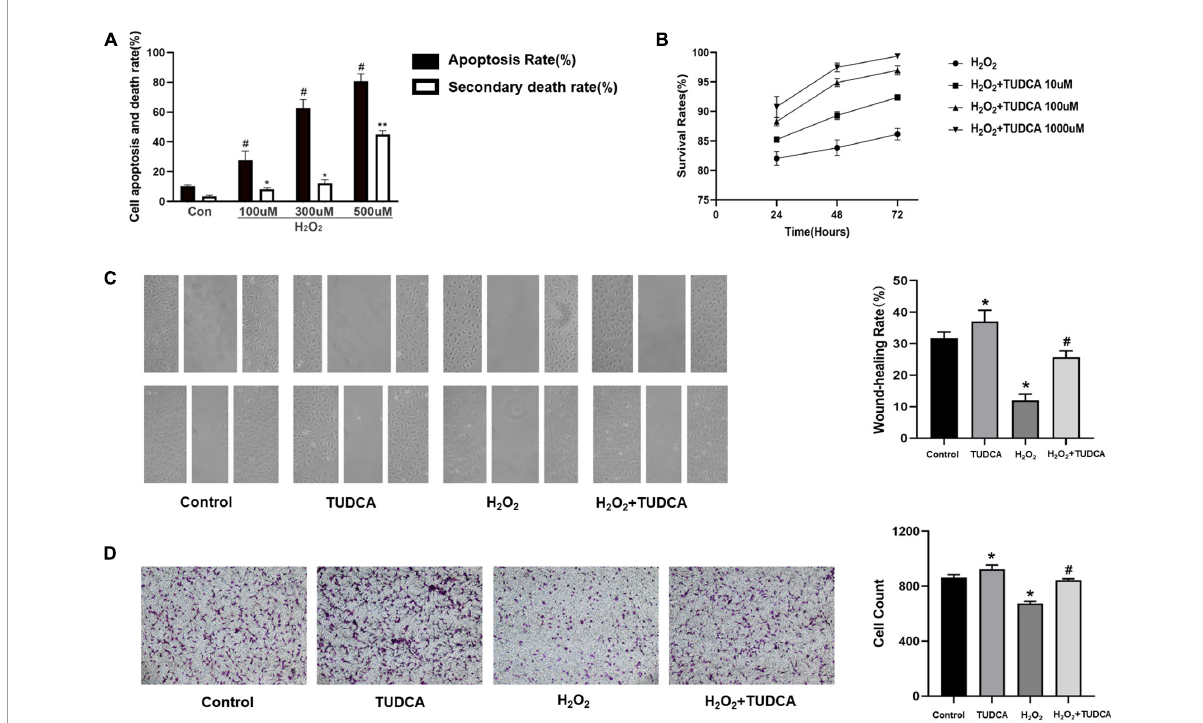
FIGURE3 Tauroursodeoxycholic acid (TUDCA) promotes HUVECs proliferation and migration in vitro . (A) The levels of apoptosis (apoptosis rate) and necrosis (secondary death rate) after exposure to H 2 O 2 at the indicated doses. Values represent the percentage of cells undergoing each form of death and are presented as mean ± SD; # p < 0.05, * p < 0.05, ** p < 0.01 compared with normal HUVECs. (B) CCK-8 assay was used to assess the cell survival rate of HUVECs. TUDCA improved the survival rate of HUVEC with time and concentration dependence. (C) TUDCA promotes HUVEC migrating after H 2 O 2 induced HUVEC damage in wound-healing assay. (* P < 0.05 vs. control group, n = 3; # P < 0.05 vs. H 2 O 2 group, n = 3). (D) TUDCA promotes HUVEC migrating after H 2 O 2 induced HUVEC damage in cell migration assay. (* P < 0.05 vs. control group, n = 3; # P < 0.05 vs. H 2 O 2 group, n =